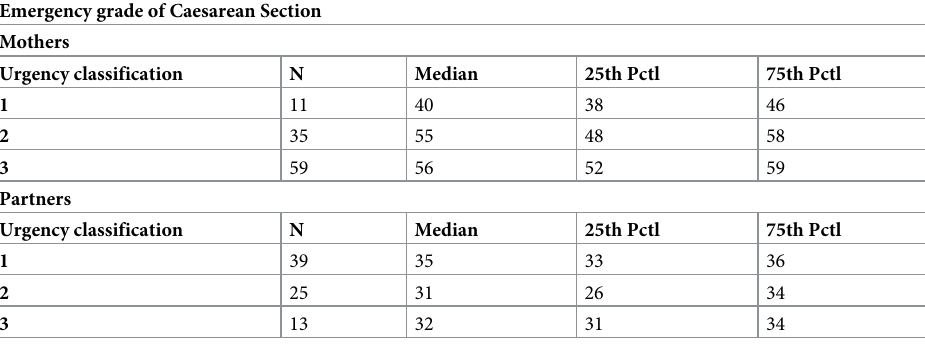
Table 5. Association between urgency classification of caesarean section and perceived quality of care measured as median questionnaire scores by mothers and partners Legend: The results represent sum-score values of per- ception of care reported in the questionnaires ranging from zero to 60. Pctl: Percentiles.